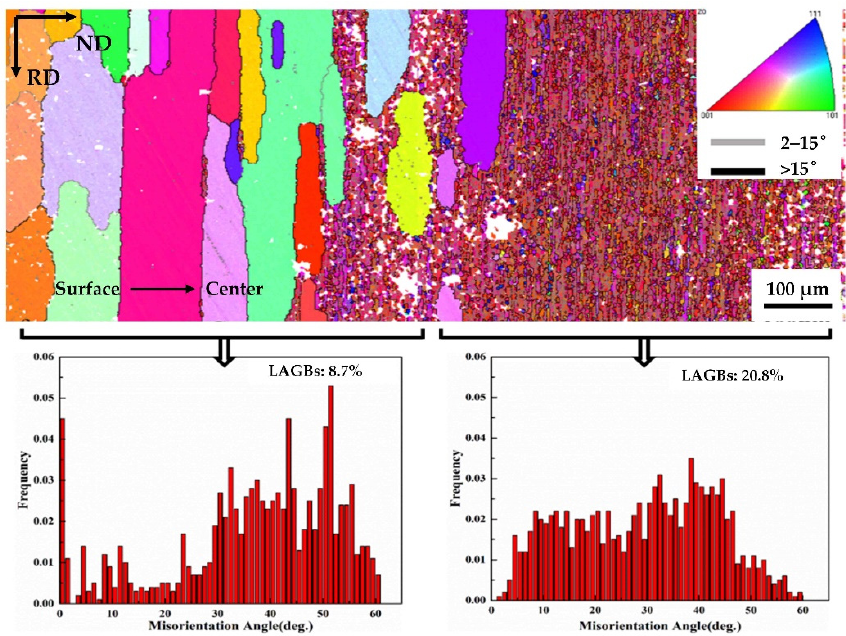
Figure 10. Inverse pole figure map viewed along TD direction and misorientation maps of the solution treated 2195 alloy without homogenization, from the edge to the center.